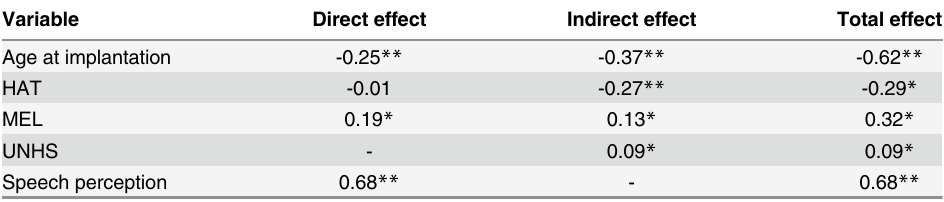
Table 5. Standardized direct, indirect, and total effects of variables on vocabulary (N = 115).